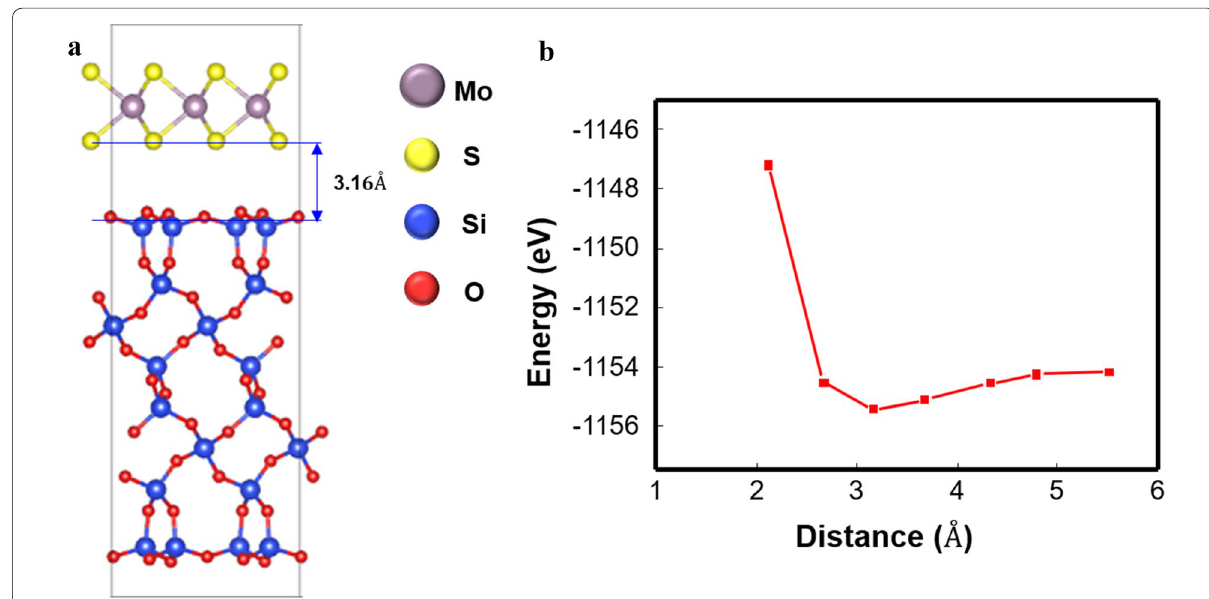
Fig. 3 a Atomistic model of the MoS 2 layer on the single-crystal SiO 2 . b Formation energy as a function of SiO 2 -MoS 2